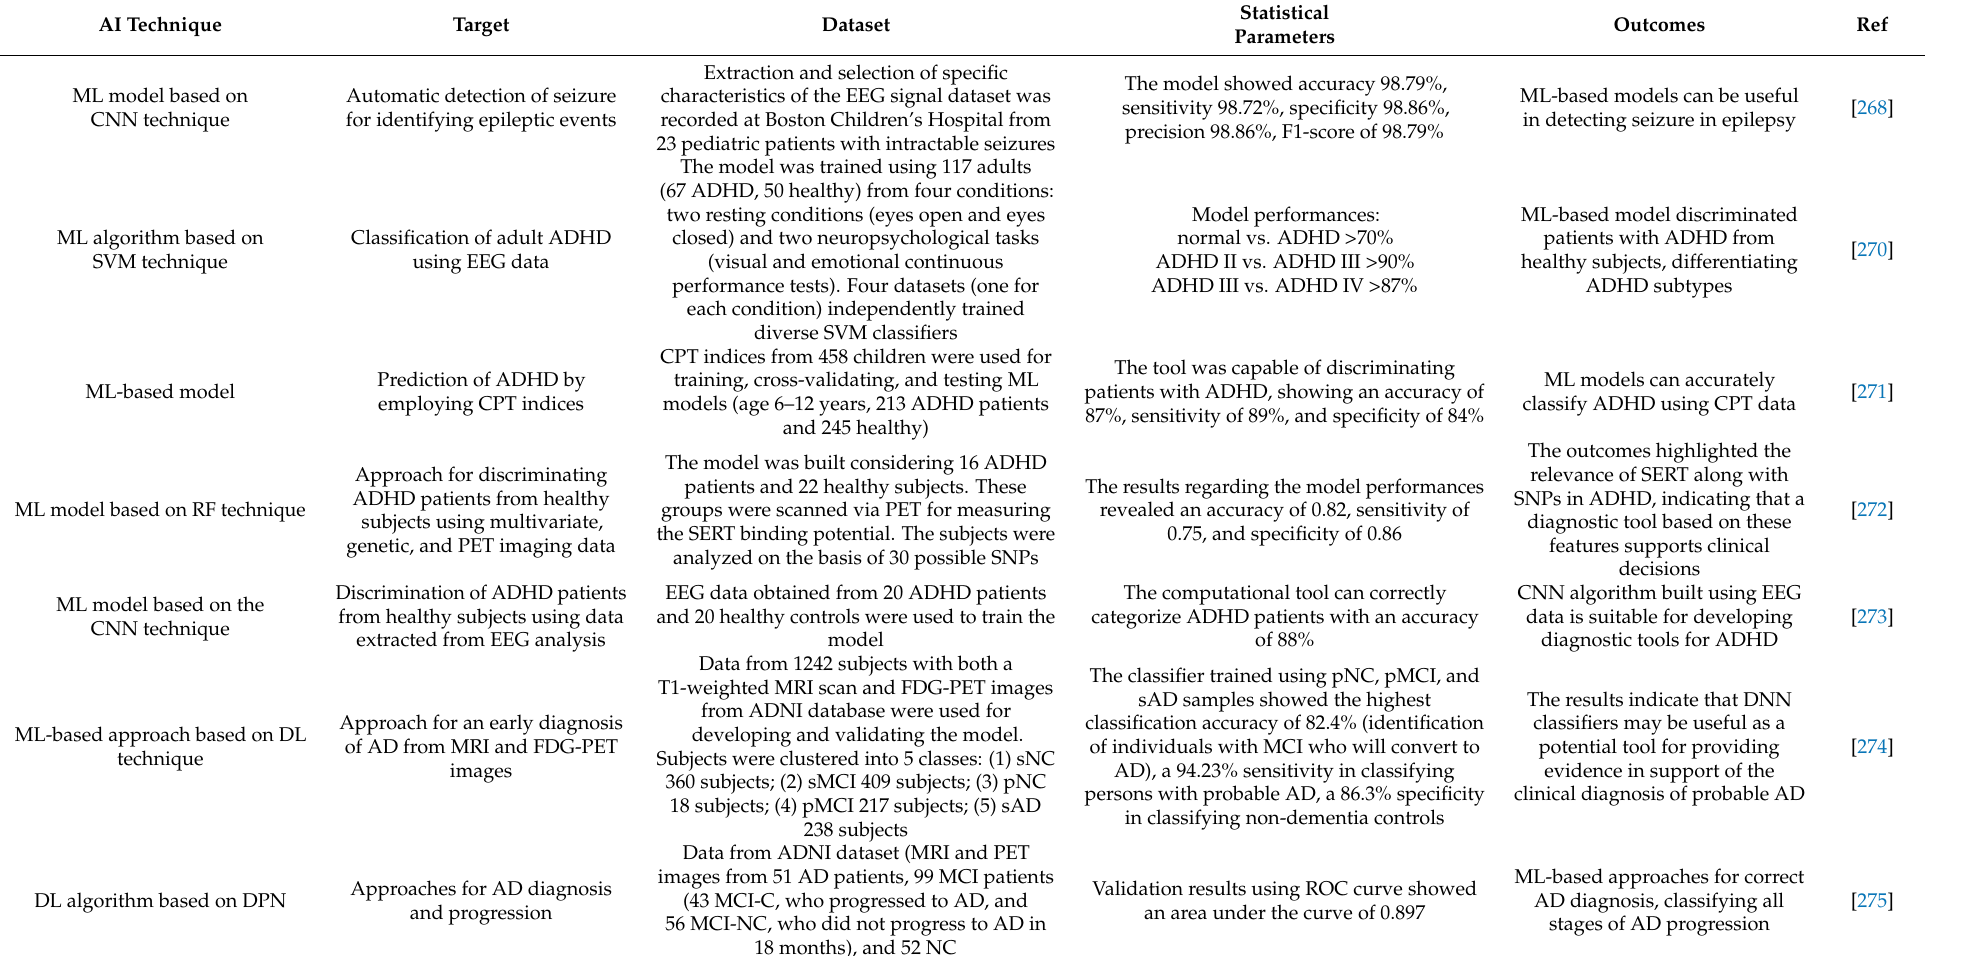
Table 6. Main examples of AI/ML in CNS-related